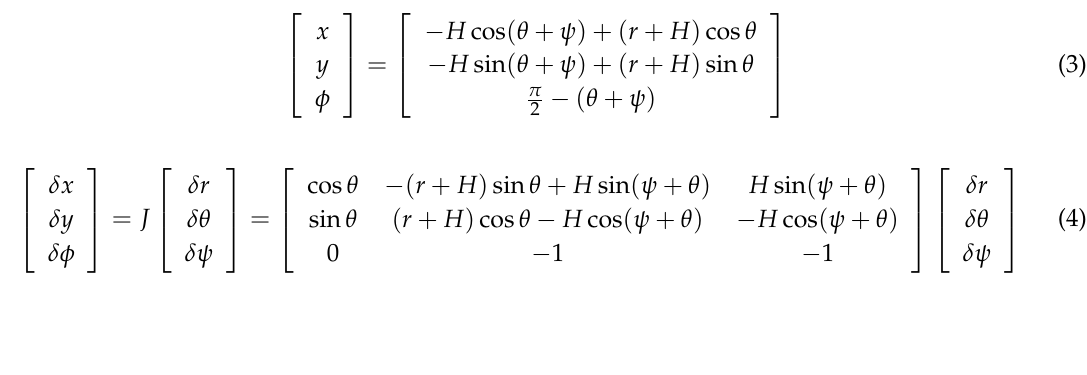
Figure 10. Geometric variables and relations in sarcopenia detection system. ( a ) Geometric variables for planar kinematics of the sarcopenia detection system. ( b ) Geometric variables for Jacobian based ultrasound scanning